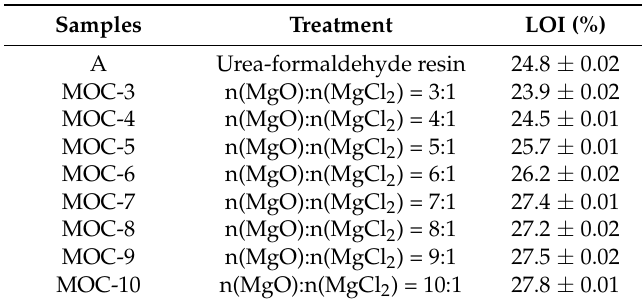
Table 6. Limited oxygen index (LOI) data of the plywood